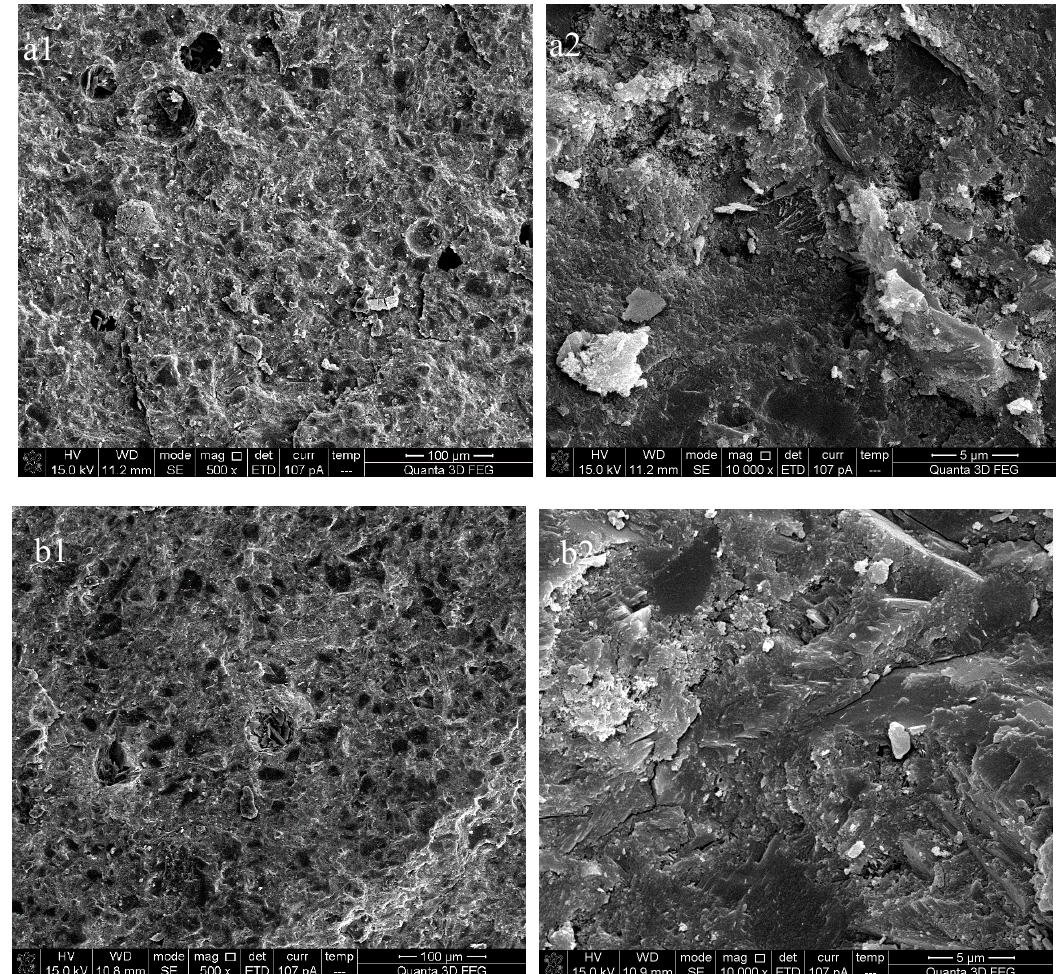
Figure 8. SEM micrographs of cement pastes. ( a1 ) NS-0.5% (500 × ); ( a2 ) NS-0.5% (10,000 × ); ( b1 ) MNS-0.5% (500 × ); ( b2 ) MNS-0.5%(10,000 × ).